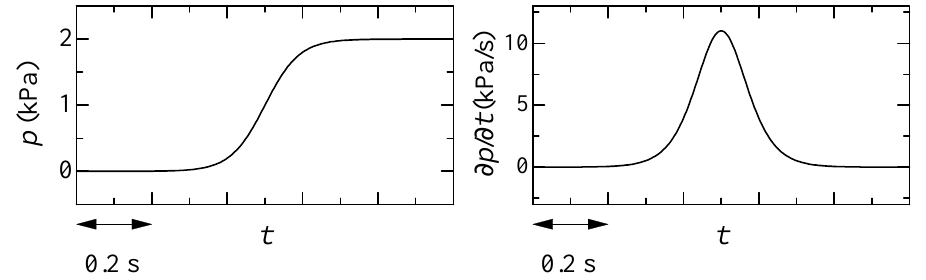
Fig. 2 Compression waveforms expressed in Eq.